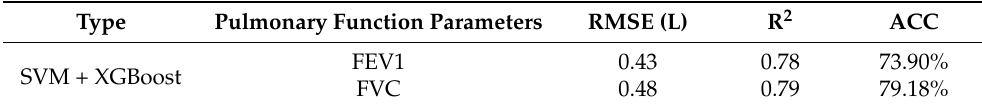
Table 4. Results of the conventional machine learning